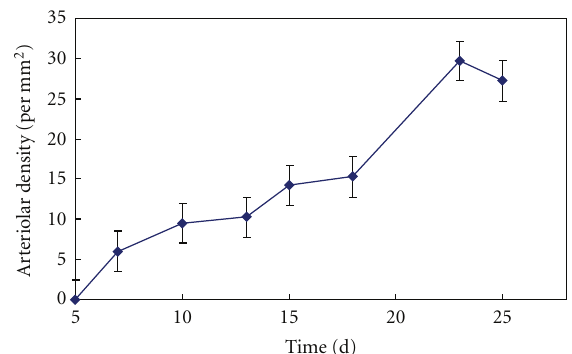
Figure 5: The curve of arteriolar density change with time in